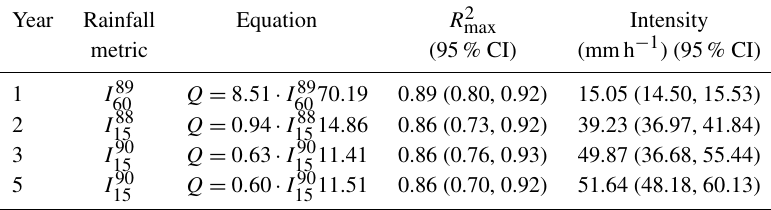
Table 2. The linear regression-based optimal rainfall ID metrics and corresponding rainfall thresholds for flash floods in post-fire years 1–5.